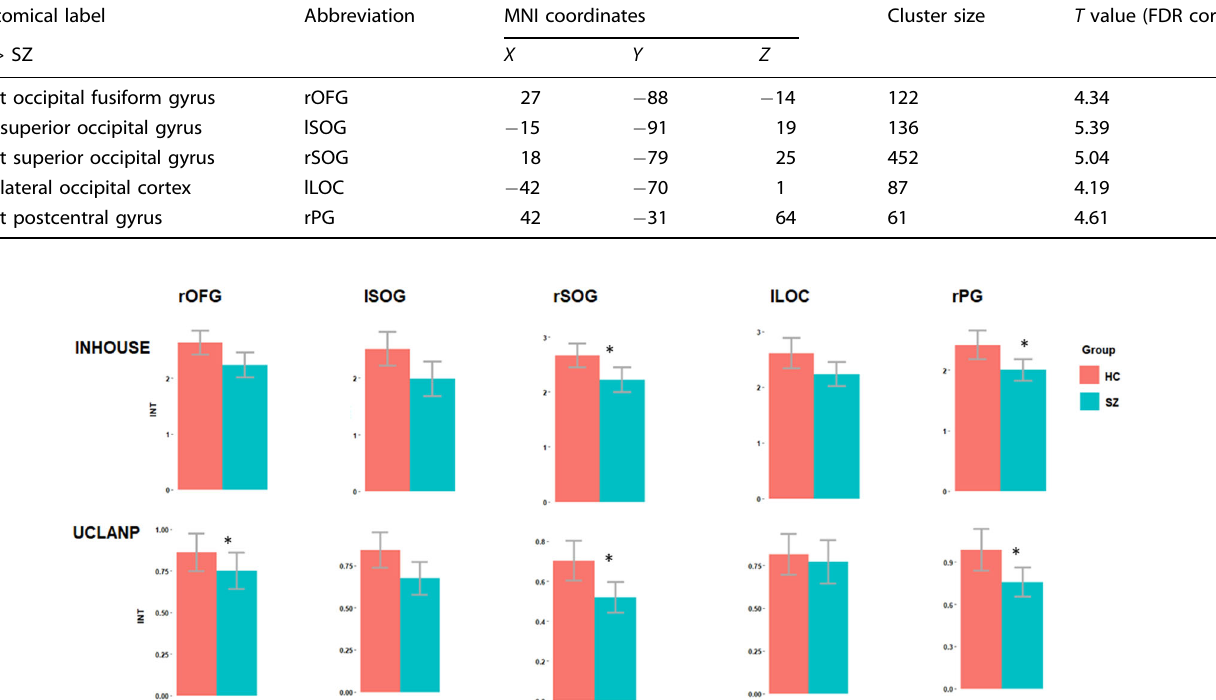
Table 2. Voxel-wise INT-group differences.